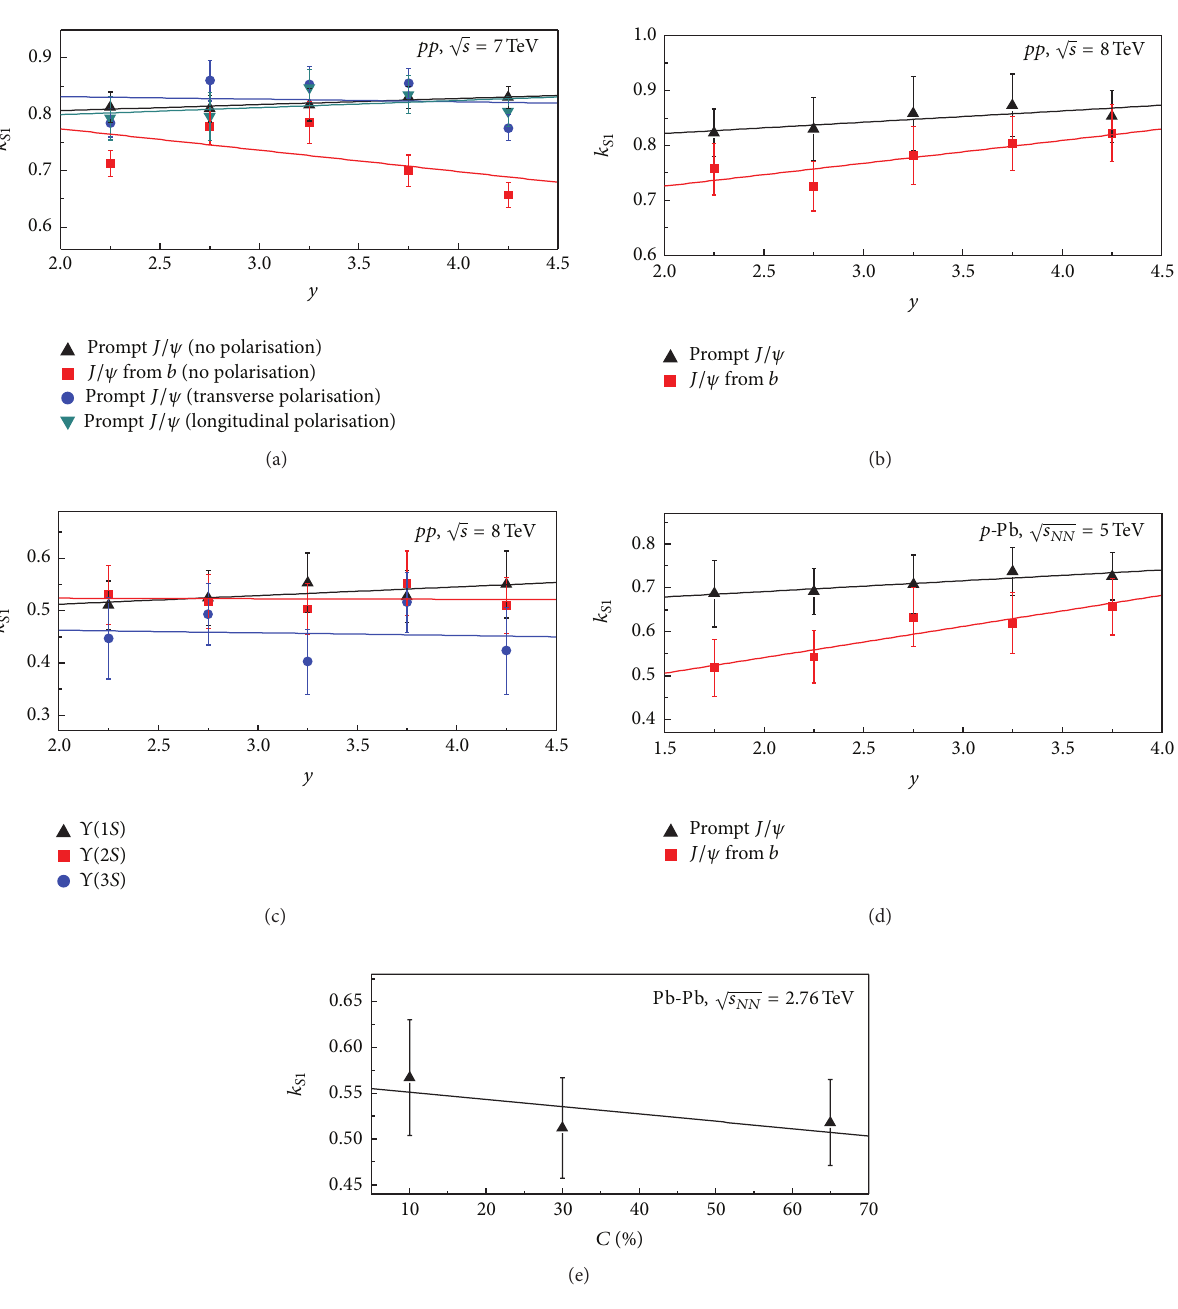
Figure 9: The same as Figure 6 but showing the results for 𝑘 𝑆1